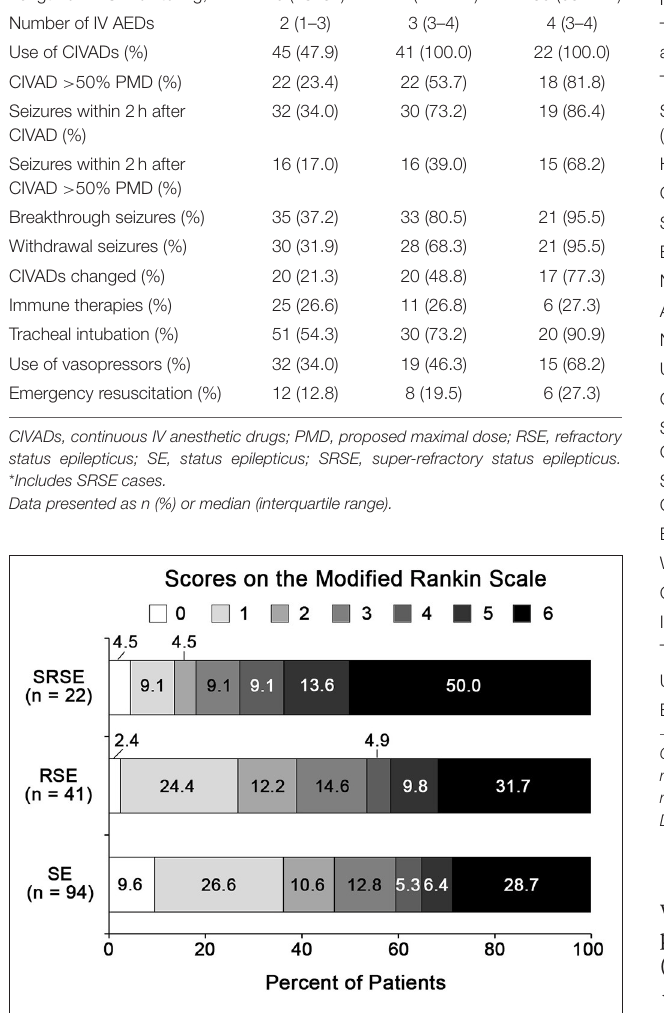
FIGURE 2 | Three-month functional outcomes of SE in acute encephalitis. 0, no symptoms; 1, no significant disability; 2, slight disability; 3, moderate disability; 4, moderately severe disability; 5, severe disability; 6, dead. RSE, refractory status epilepticus; SE, status epilepticus; SRSE, super-refractory status epilepticus.